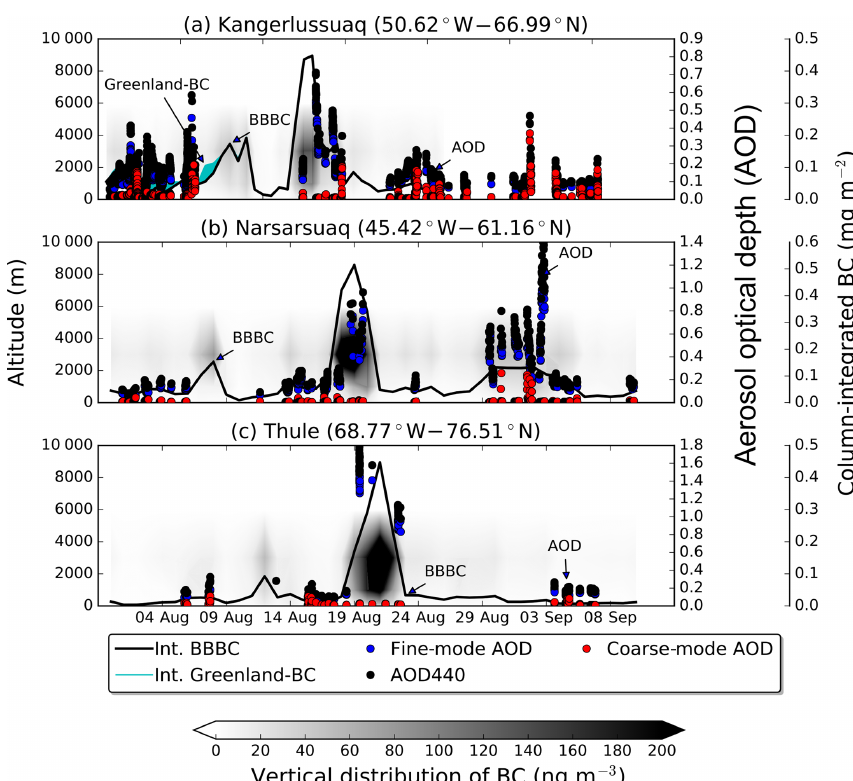
Figure 5. Contour plot of the vertical distribution of simulated BC (altitude a.g.l. shown on left y axis) as a function of time ( x axis) and time series of column-integrated simulated BC (extended right axis) from fires burning outside Greenland (black line) and Greenland fires (cyan stacked area). Column-integrated BC from anthropogenic sources was extremely small and it is not plotted here. Time series for fine-mode (blue) and coarse-mode (red) AOD at 500nm and total AOD at 400nm (black) correspond to the right y axis. The three panels show results for stations (a) Kangerlussuaq, (b) Narsarsuaq and (c) Thule (sorted from the closest to the farthest